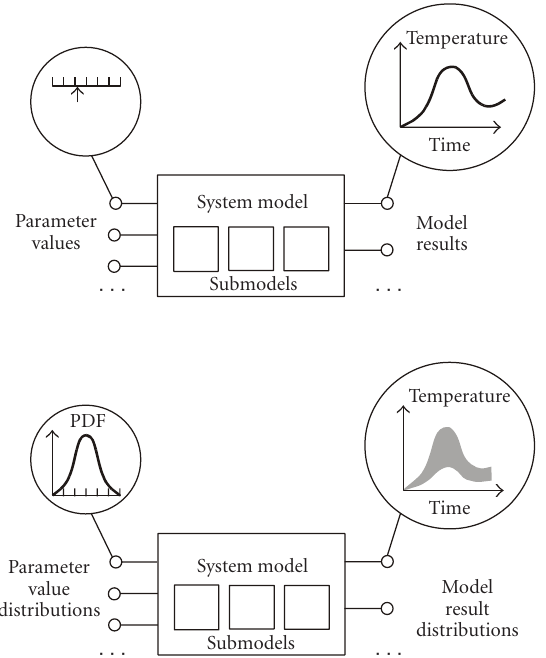
Figure 2: Consideration of input parameter value ranges instead of discrete values in the GRS